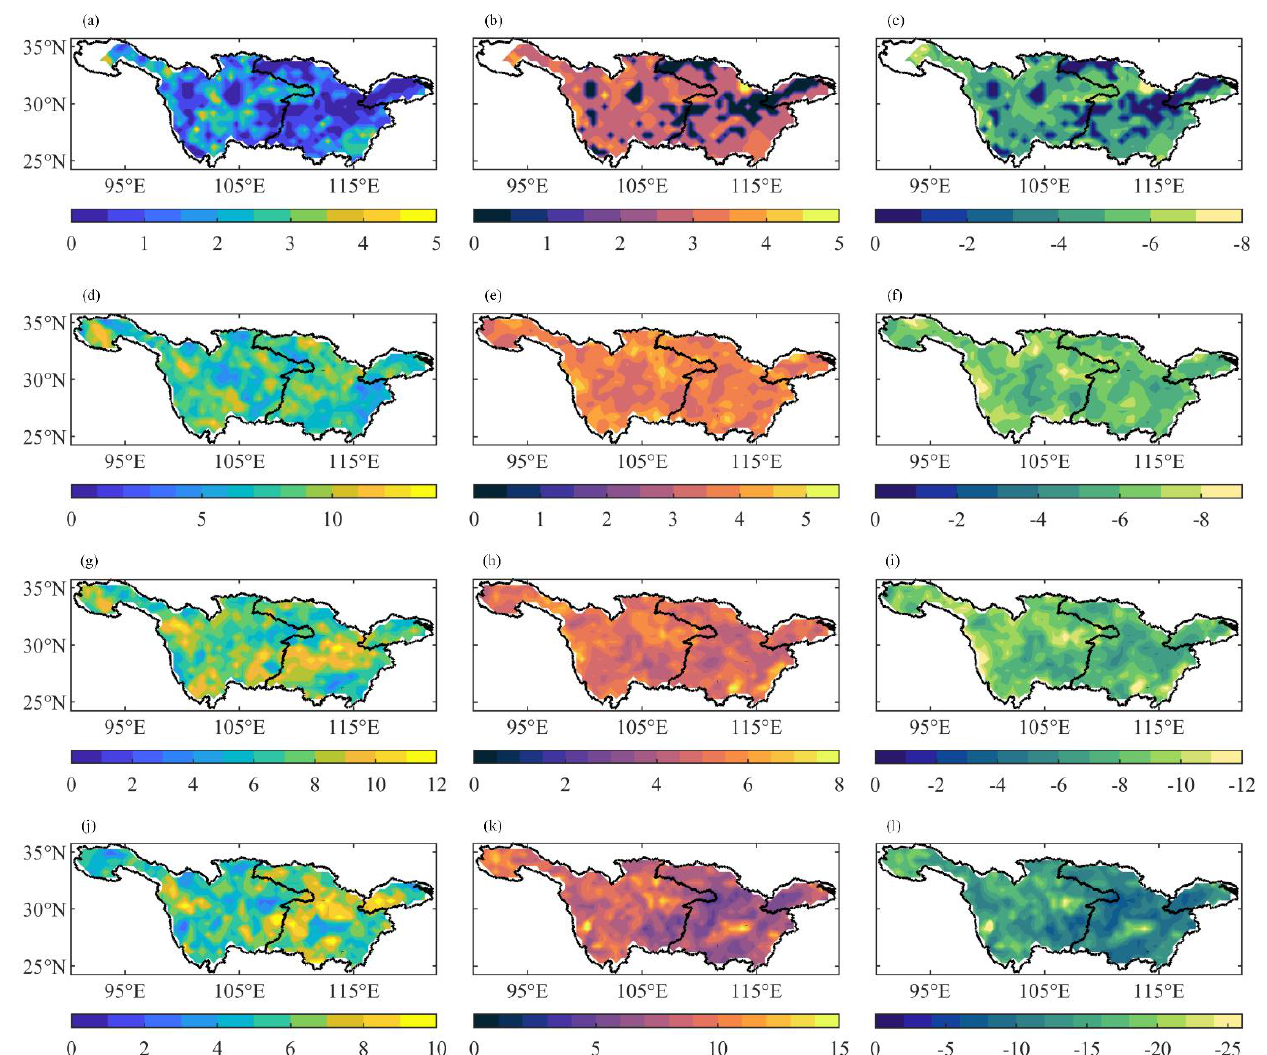
Figure 3. Drought Characteristics in the Yangtze River basin from 1981 to 2010 in the 1-month ( a – c ), 3-month ( d – f ), 6-month ( g – i ) and 12-month ( j – l ) scale, with the first column showing the number of drought events, the second showing the average duration (month), and the last showing the average severity.